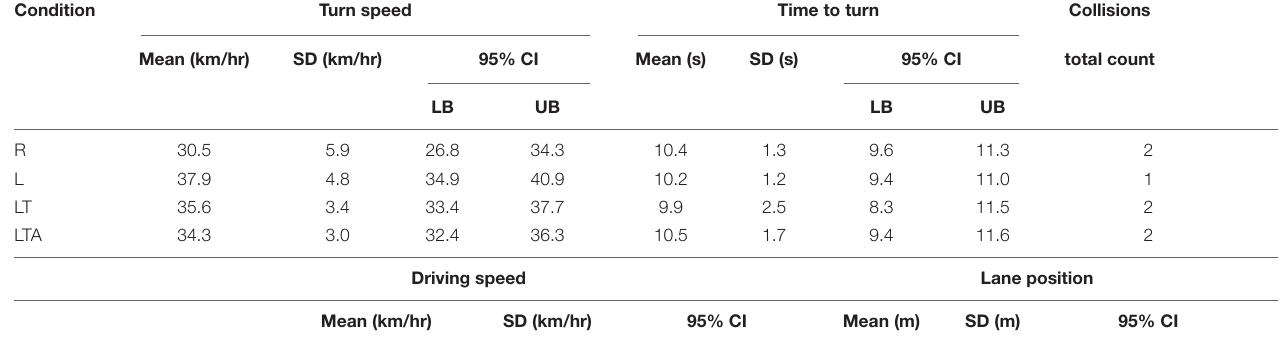
TABLE 1 | Descriptive statistics of behavioral metrics of simulated driving performance: turn speed, time to turn and number of collisions in the turning tasks (R, L, LT, and LTA), driving speed and lane position in straight driving tasks (S, SA), and response time and response accuracy in audio tasks (SA, LTA). Condition Turn speed Time to turn